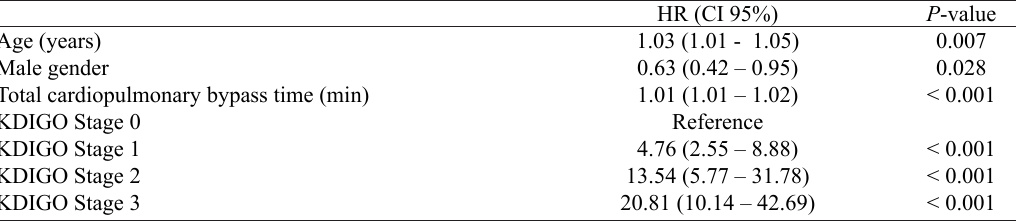
Table 6. Cox proportional hazard model considering all patients who underwent cardiac surgery for predictors of 30-day mortality.